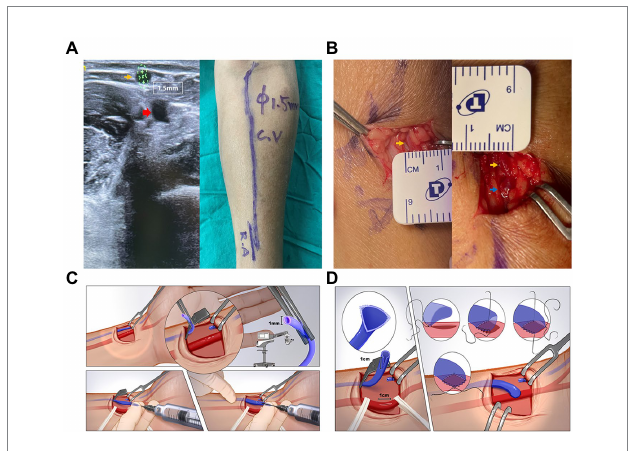
FIGURE 1 (A) Preoperative vascular ultrasound image (left) and whole-course vessels marking (right) of the distal left forearm. The vessel diameter was measured with a tourniquet. The yellow arrow indicates the cephalic vein, which is around 1.5 mm. The red arrow indicates the radial artery. (B) Cephalic vein measurement before (left) and after (right) end-to-side anastomosis. The yellow arrow indicates the cephalic vein and the blue arrow indicates the anastomotic site. (C) Detailed schematic diagram of the vein hydro-dilation stage. (D) Detailed schematic diagram of the fistula anastomosis